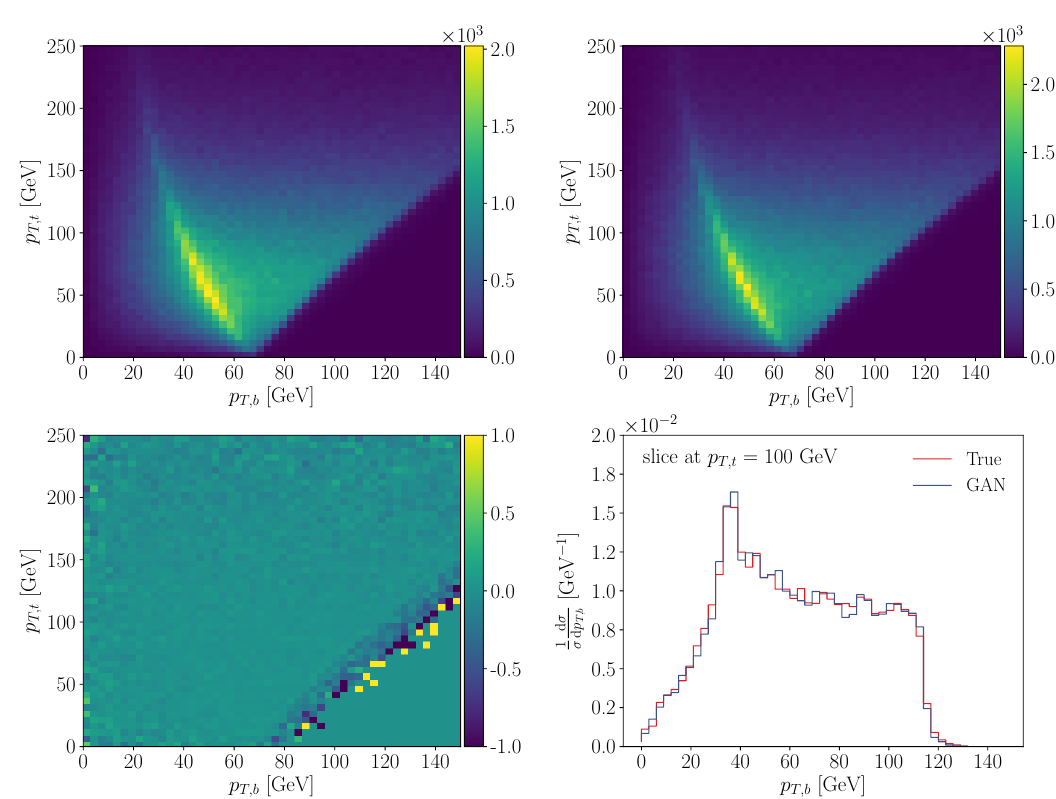
Figure 9: Correlation between p and p for the true data (upper left), GAN data T , t T , b (upper right) and the asymmetry between both (lower left). In addition, we show = 100 ± 1 GeV (lower p sliced at p T , b T , t